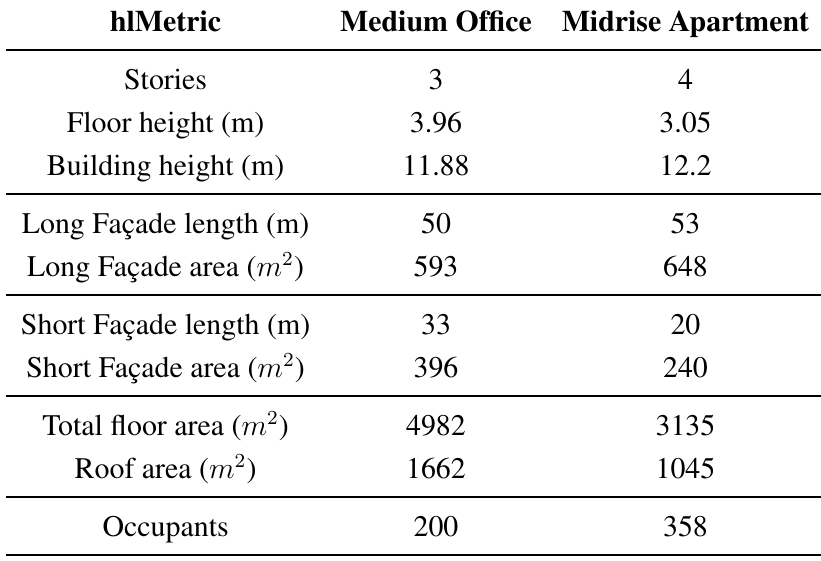
Table 6. Energy simulation parameters for photovoltaic cladding